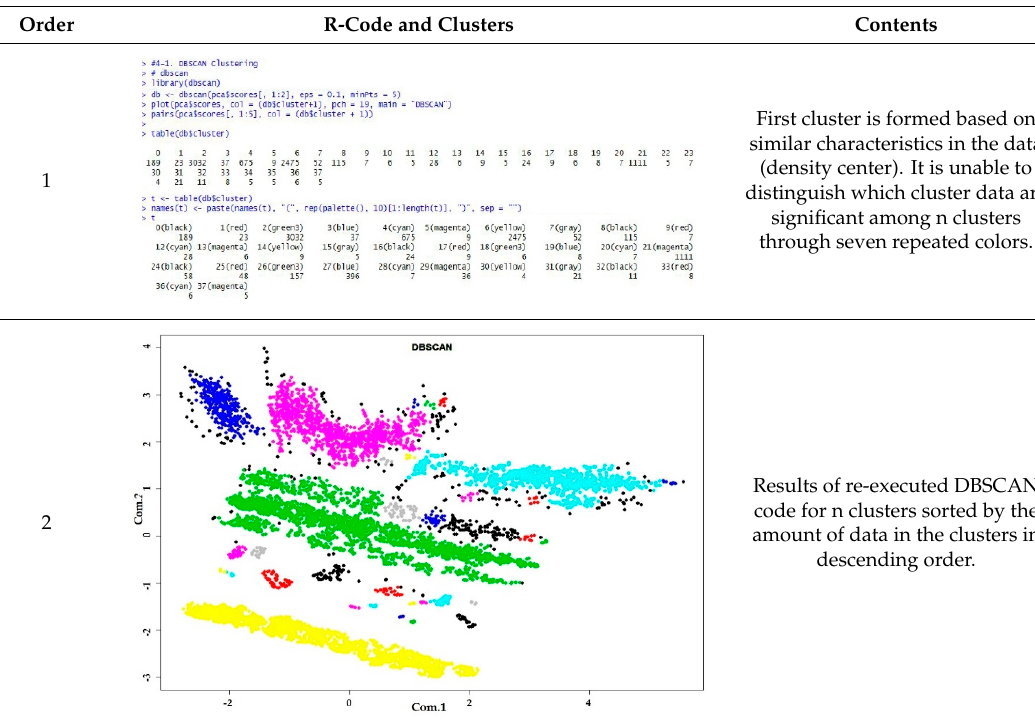
Results of re-executed DBSCAN code for n clusters sorted by the amount of data in the clusters in descending